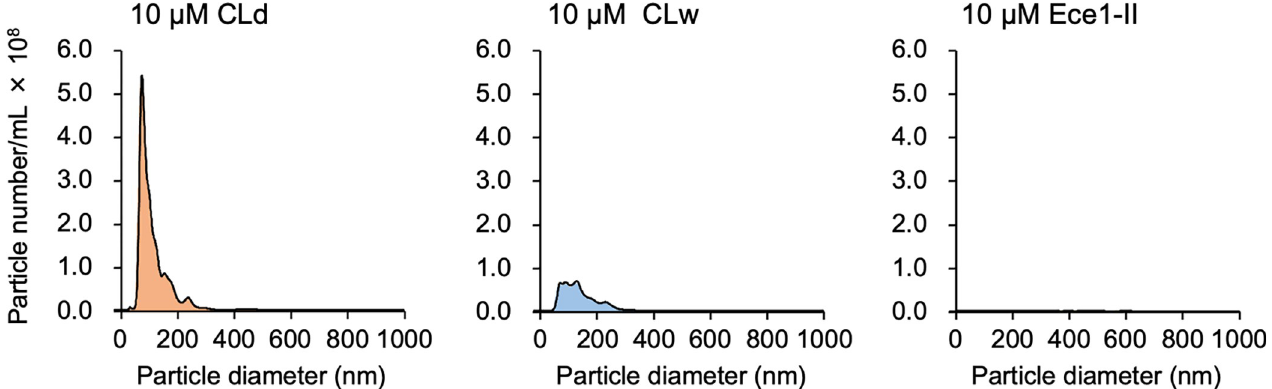
Fig 8. Detection of nanoparticles in CLd and CLw. Analyses of the number and size of nanoparticles in 10 μ M CLd, CLw, and Ece1-II control peptide were performed using a NanoSight NS300 nanoparticle characterizer. Data are presented as the mean of five independent experiments.